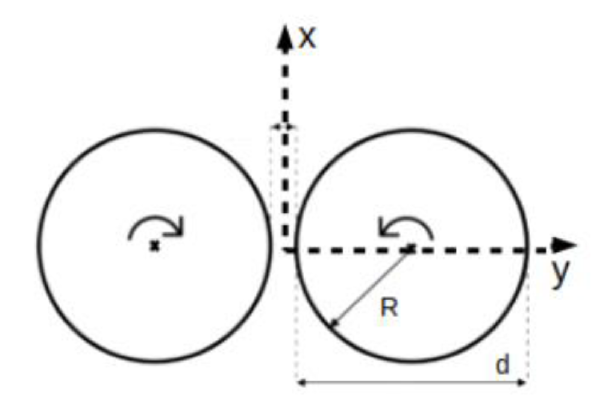
Figure 1. Sketch of the examined configurations, counter-rotating